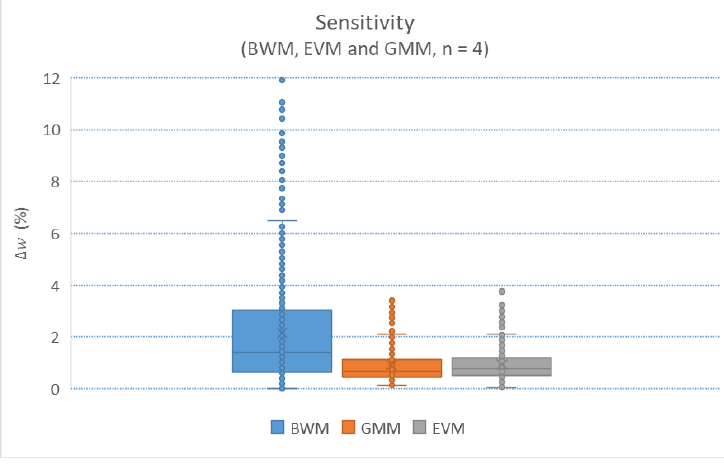
Figure 4. Sensitivity distribution: all methods, n =